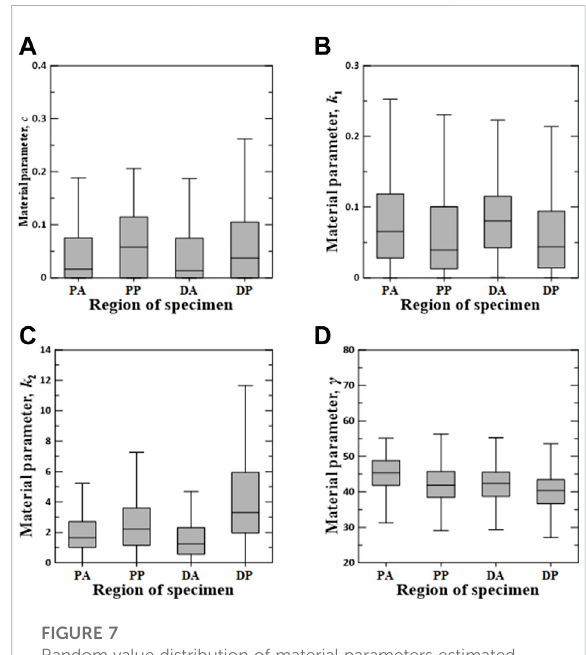
FIGURE 7 Random value distribution of material parameters estimated using Holzapfel model for PA, PP, DA, and DP specimens. (A) c , (B) k 1 , (C) k 2 , and (D) γ